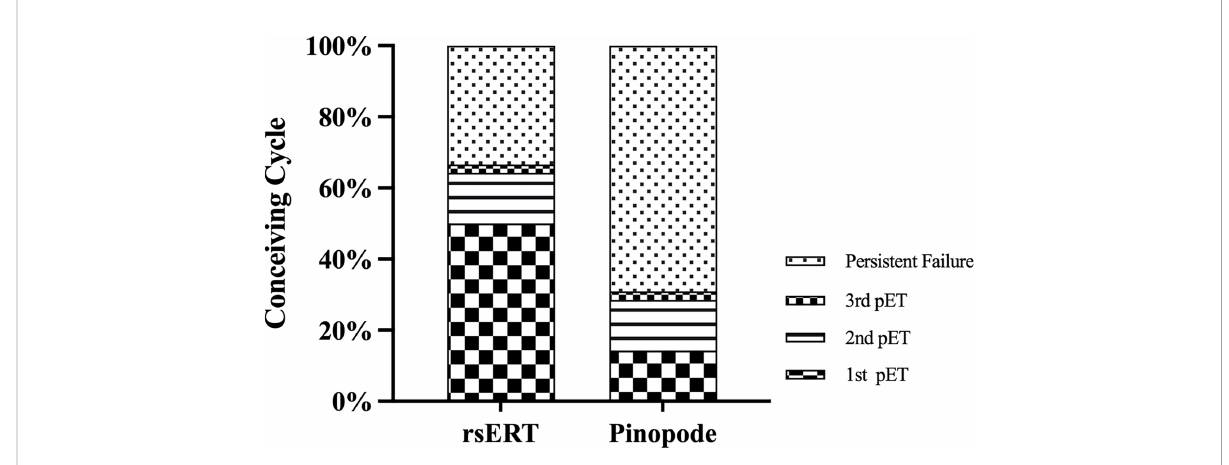
FIGURE 3 Histogram with the distribution of conceiving cycle between the groups. Patients in the rsERT group have a higher successful pregnancy rate and require fewer ET